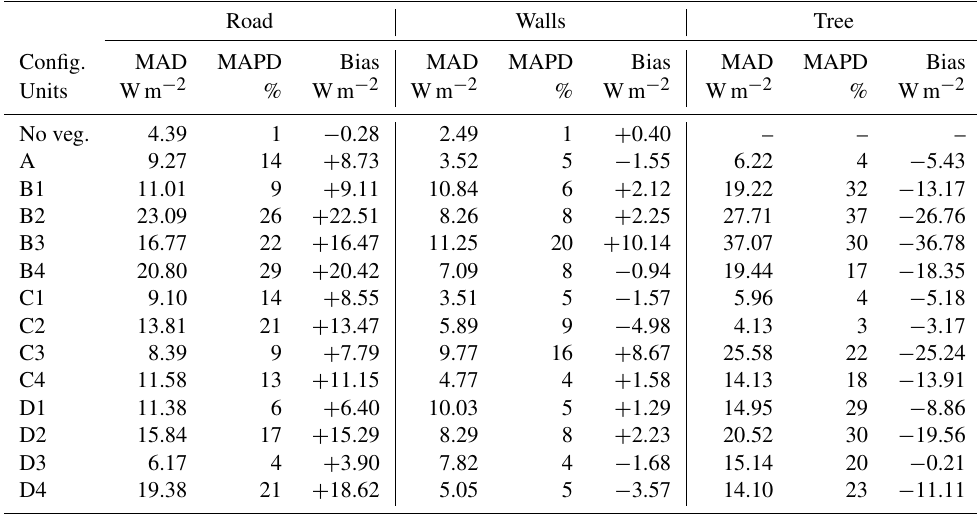
Table 4. Statistical scores for direct solar radiation received by surfaces before multiple reflections for summertime. Road Walls Tree Config. MAD MAPD Bias